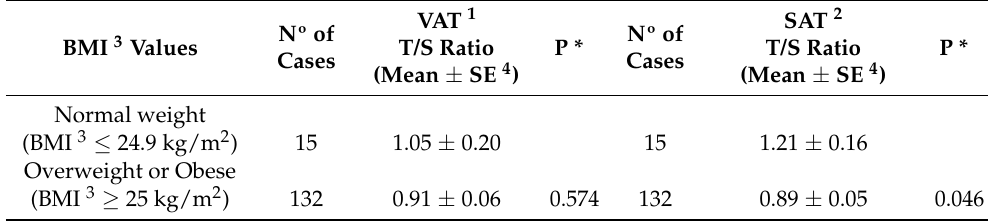
Table 1. Telomere length, measured as T/S ratio, in visceral and subcutaneous adipose tissues, in relation to the body mass index. Nº of